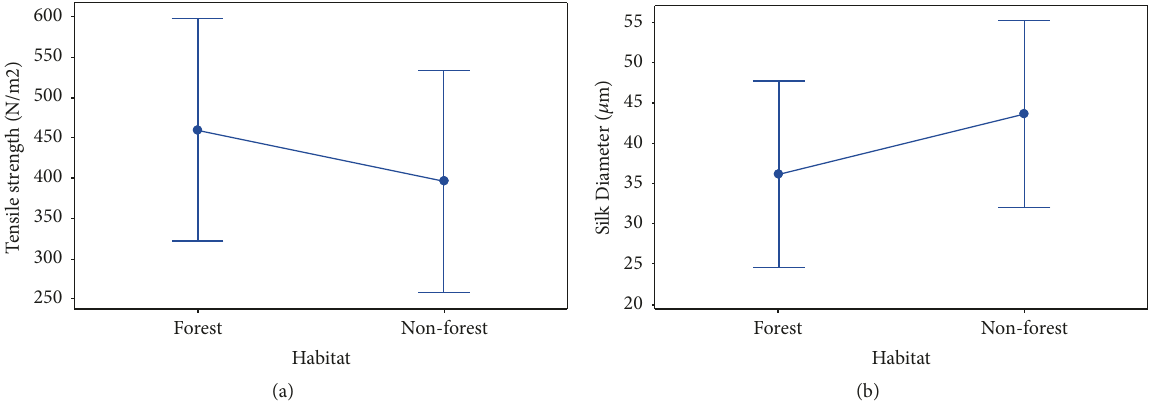
Figure 4: Variation in properties of silk thread (a) tensile strength and (b) diameter of silk thread in webs of N. pilpes found in forest and nonforest habitats.